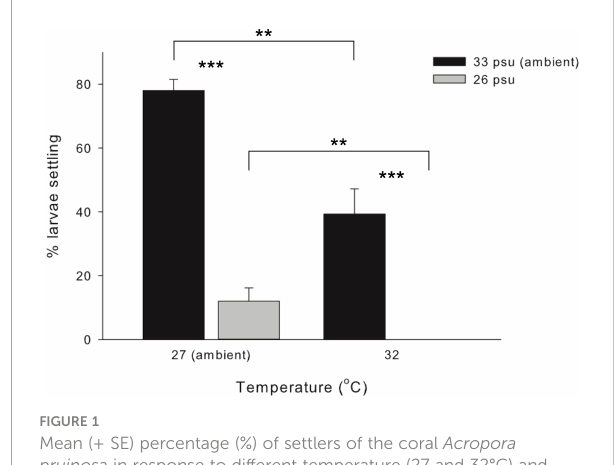
FIGURE 1 Mean (+ SE) percentage (%) of settlers of the coral Acropora pruinosa in response to different temperature (27 and 32°C) and salinity (33 and 26 psu) treatments (n = 3 replicates per treatment). Results from Two-way ANOVA demonstrate a signi fi cant effect of temperature ( p < 0.001) and salinity ( p < 0.001), with no signi fi cant interaction among stressors ( p = 0.569). Pairwise comparisons with Bonferroni corrections showed signi fi cant differences between temperature and salinity treatments (** p < 0.05, *** p <